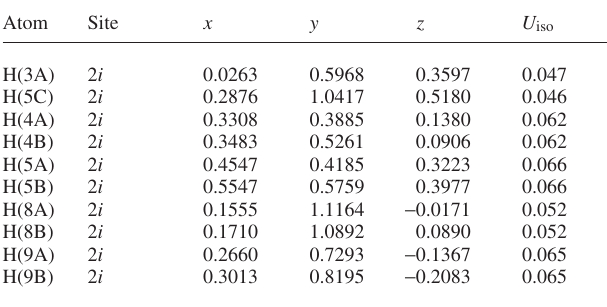
Table 2. Atomic coordinates and displacement parameters (in Å 2 ) .